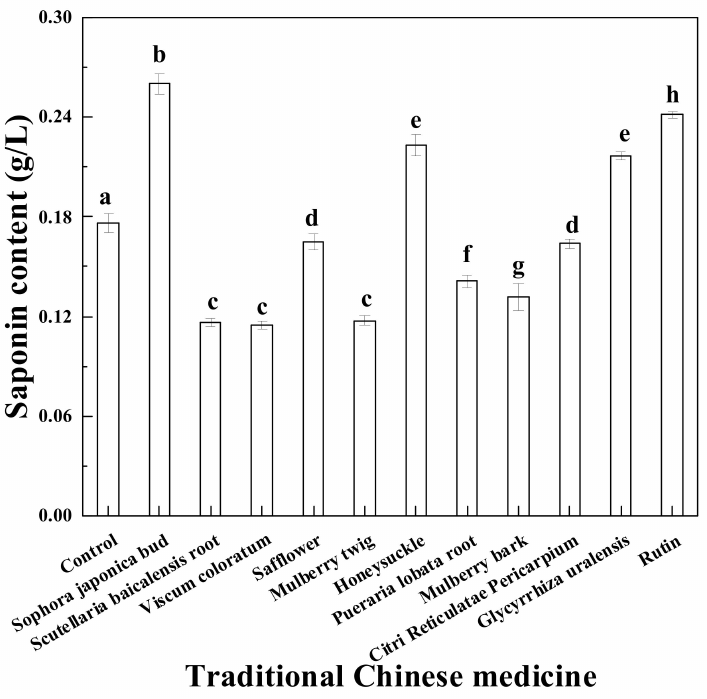
Figure 5. Effects of Chinese medicine on the saponin production of T. melanosporum . (Different letters on the top of column indicate significant differences between means: a, b, c, d, e, f, g, h, p <